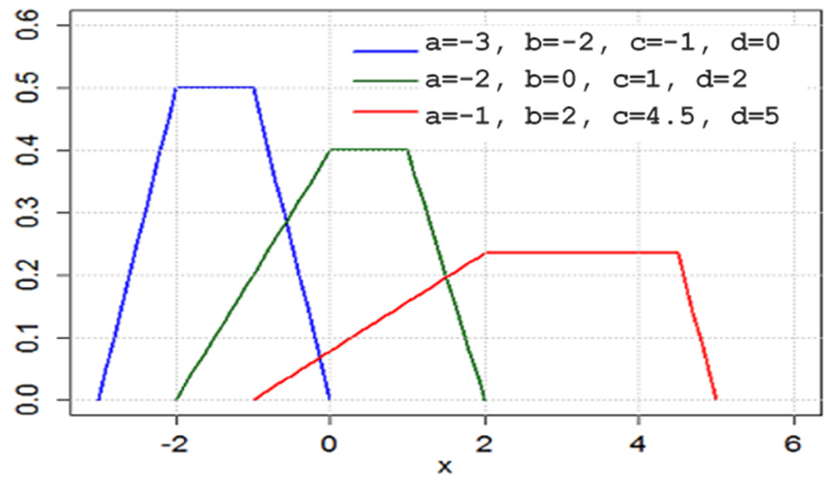
Figure 4. Trapezoidal distribution functions for a specific data set.